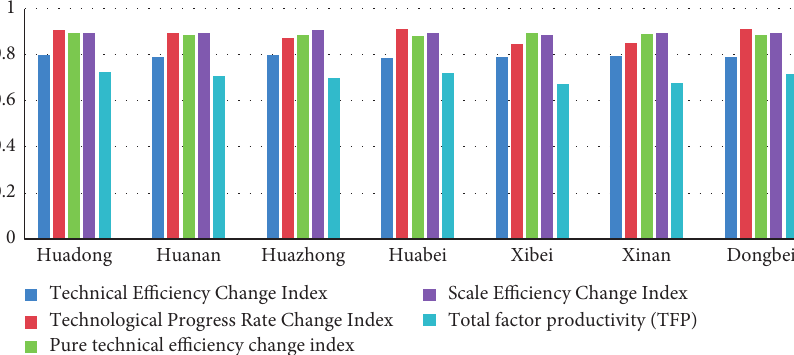
Figure 2: 2001–2017 national total factor productivity trends by region.